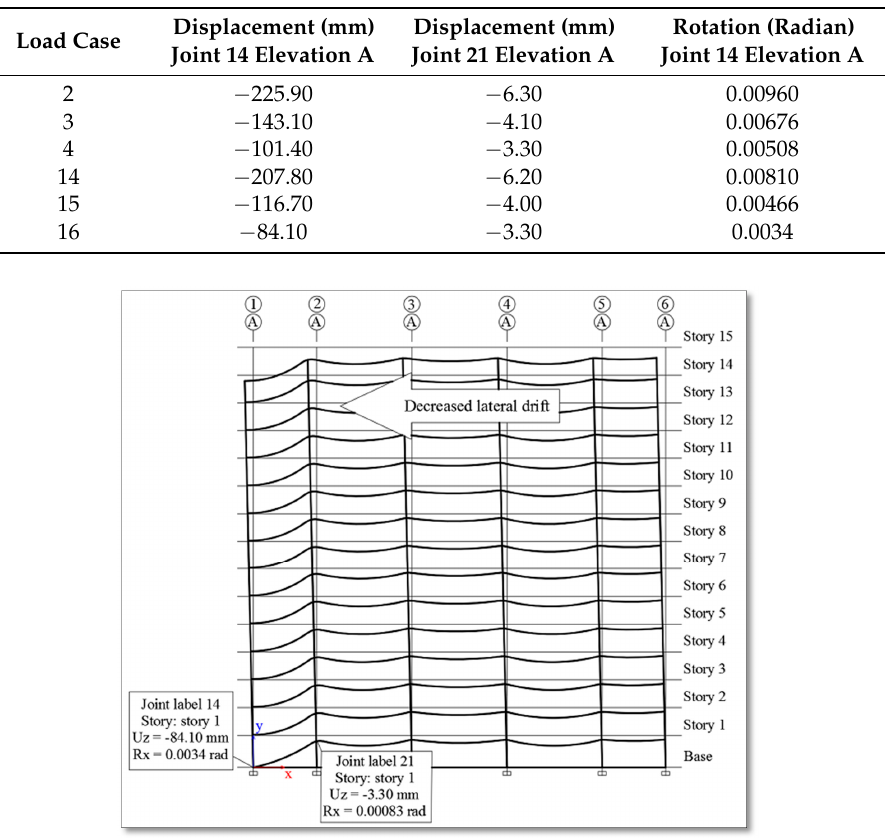
Figure 8. Deformation response of the structure at grid line A due to the notional removal of column A1 when moment frames are located at perimeters only (load case 4, non-linear dynamic analysis). U z is the vertical deformation (mm) and Rx is the rotation (radians) about the x-axis.